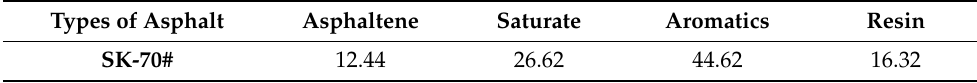
Table 2. Proportion of four components of SK-70 base asphalt (%) [22].